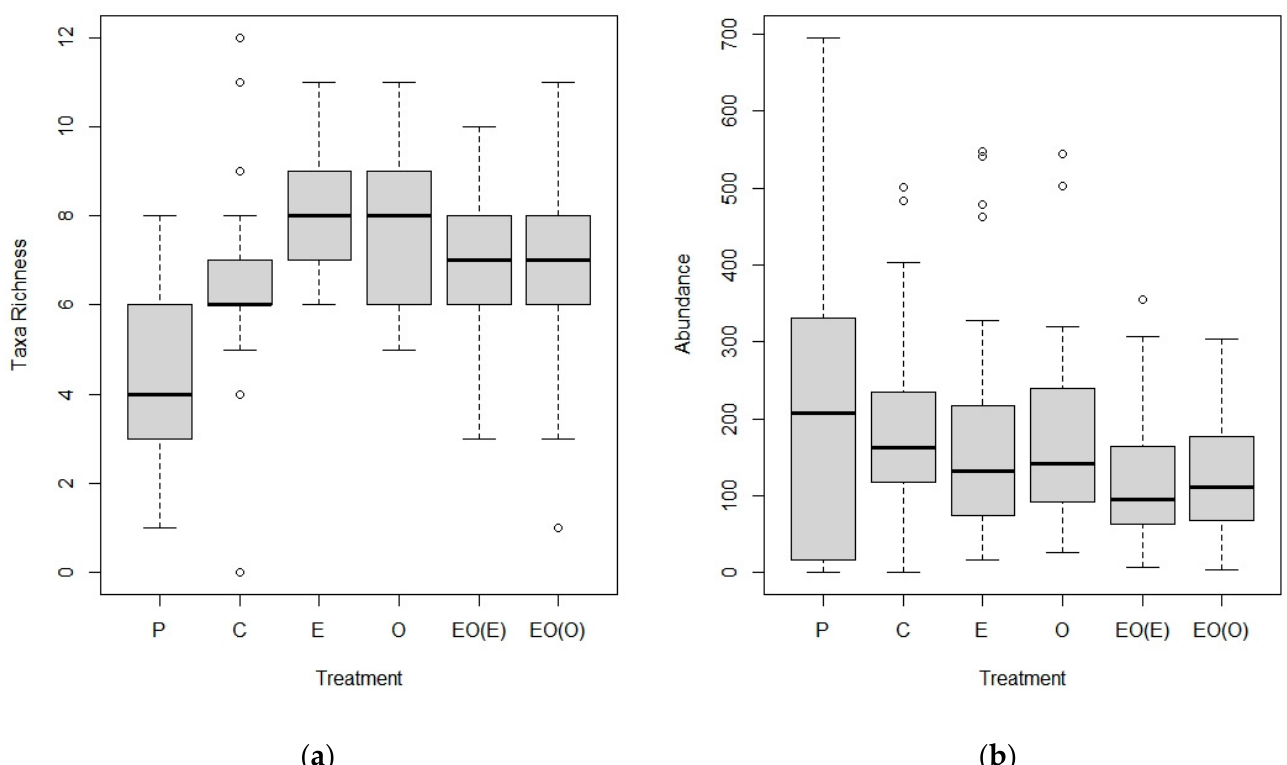
Figure A1. Taxa richness ( a ) and total abundance ( b ) of suction-sampled invertebrates per sample, pre-treatment (four sampling periods pooled for Oct 2011–July 2012 for n = 24 samples) and across all quarterly post-installation sampling periods: (six sampling periods pooled for Aug 2013-Aug 2015, for n = 30 samples per treatment). Treatments included: P = pre-treatment, C = control, E = eelgrass, O = oyster, EO(E) = eelgrass from combination plots, EO(O) = oyster from combination plots. Upper whisker is 3rd quartile (Q3) × 1.5 × inner quartile range (IQR) and the lower whisker is 1st quartile (Q1) × 1.5 × IQR; dots are data points outside the whiskers.